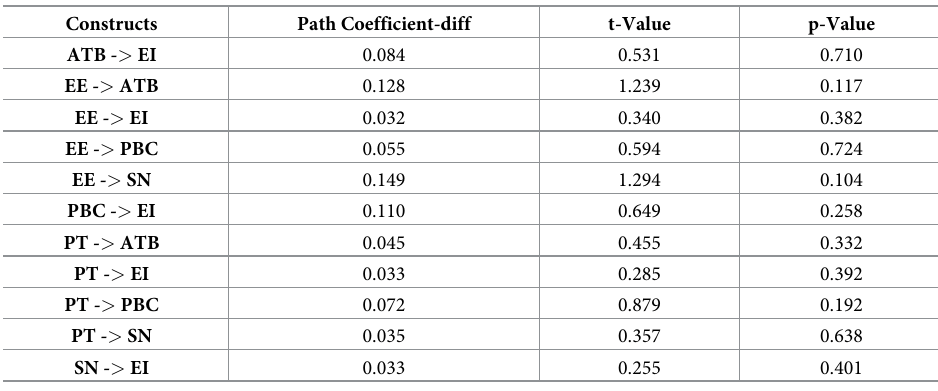
Table 8. Multi-group parametric test difference Male vs. Female.